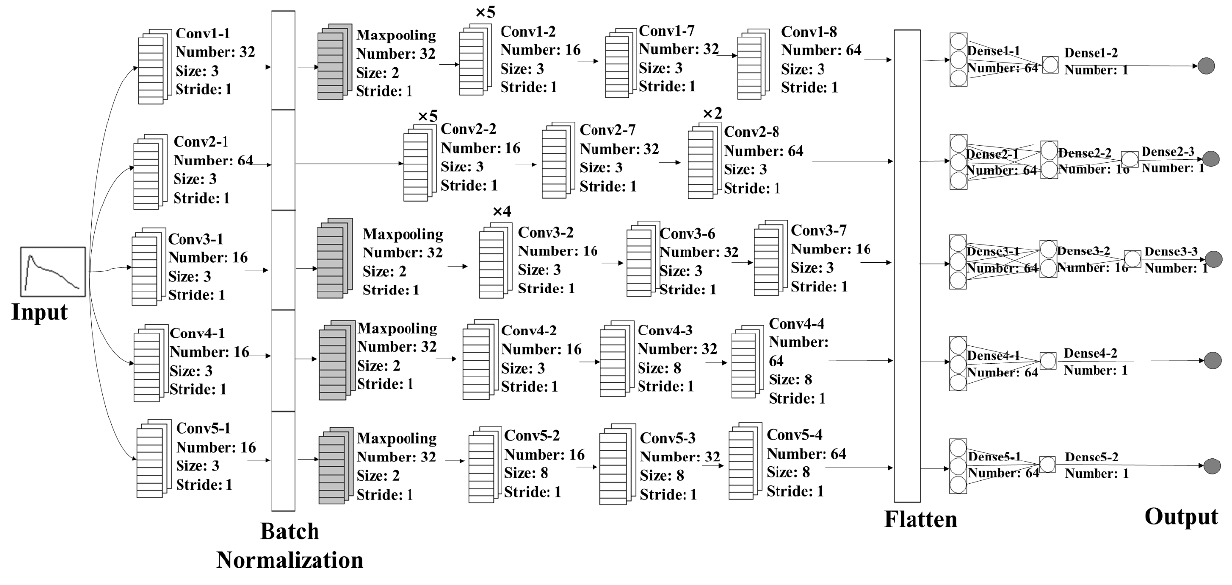
Figure 9. Architectures of the established CNN model.